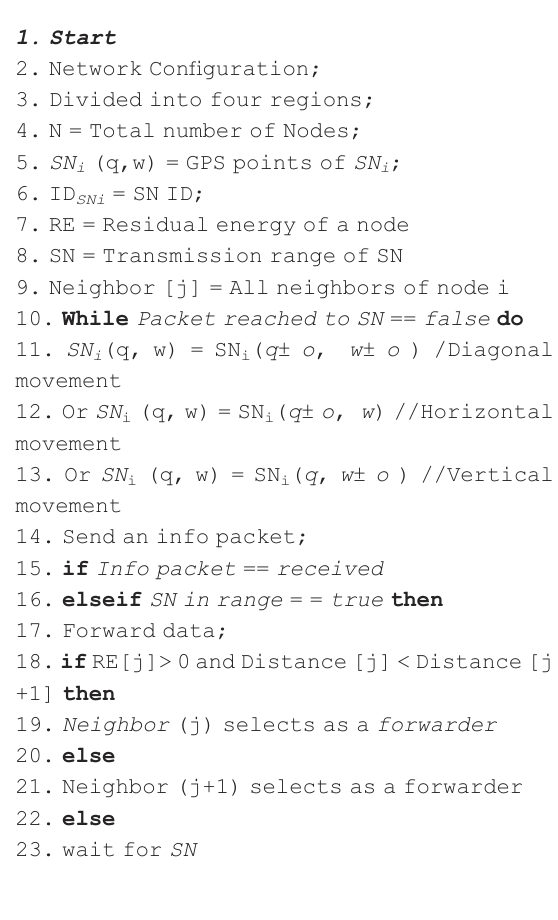
Algorithm 1 explain the proposed RACE-SM routing protocol.